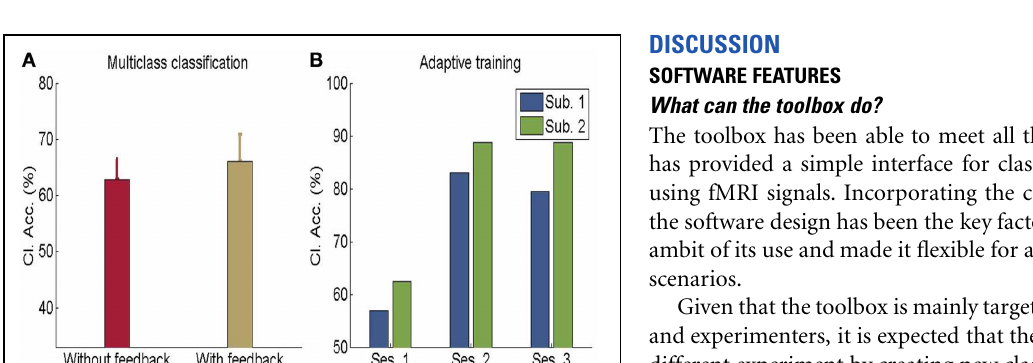
FIGURE 9 | Sample effect map for a participant performing motor imagery of left and right hands. Blue clusters depict brain areas related to the right hand execution. Similarly, red clusters show brain areas activated during the left hand execution. [Adapted from Lee et al. (2010)].